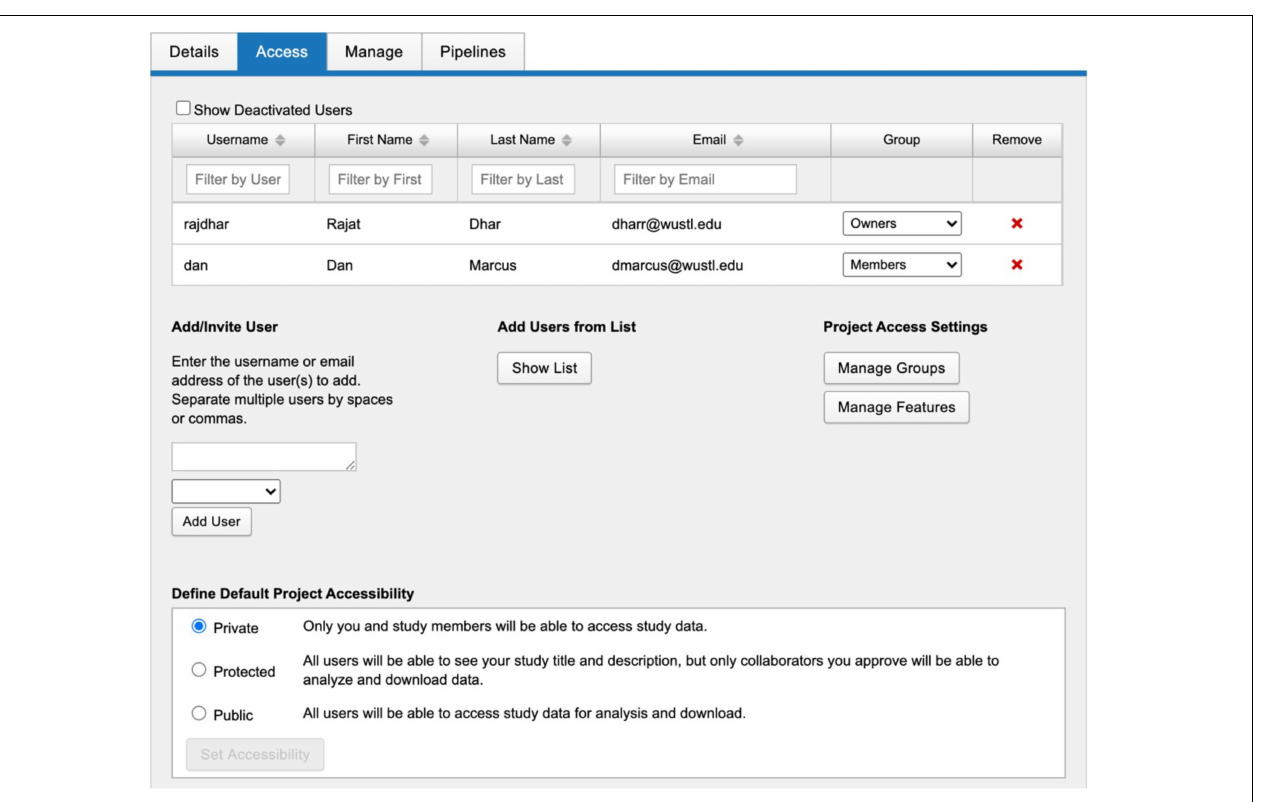
Frontiers in Neuroinformatics |